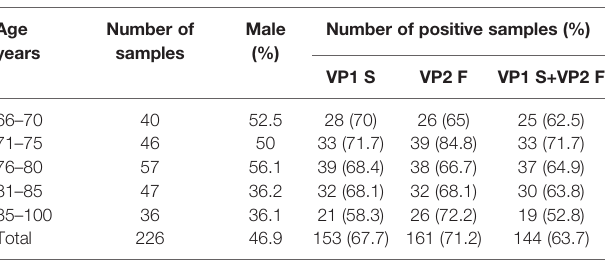
Serum samples (n = 226) were from healthy elderly subjects. Statistical analyses were performed using the two-sided chi-square test. No statistical differences were detected among age-strati fi ed groups (p > 0.05).